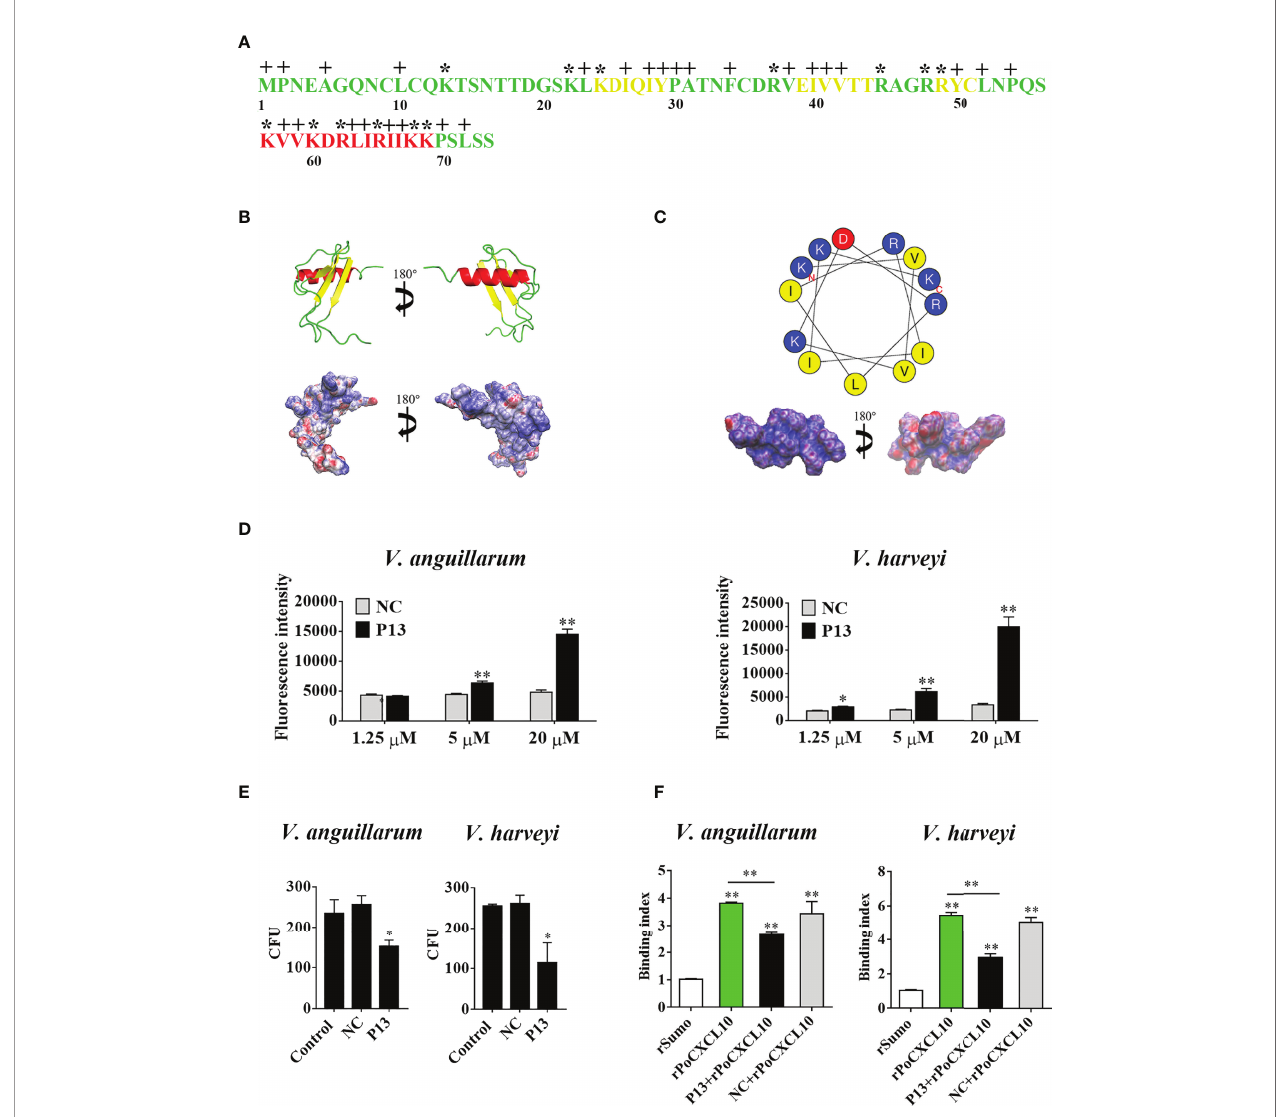
FIGURE 4 | The structure and antibacterial activity of P13. (A) The primary structure of PoCXCL10. Sequences in green, yellow, and red stand for the extended coil, b - sheet and a -helix region, respectively. Positively charged residues and hydrophobic residues are marked by “ * ” and “ + ” , respectively. (B) The secondary structure (upper) and electrostatic surface potential (lower) of PoCXCL10. In the upper panel, green, yellow, and red stand for coil, b -sheet, and a -helix, respectively. In the lower panel, the positive- and negative-charged regions are in blue and red, respectively. (C) The helical wheel (upper) and solvent accessibility representation (lower) of P13. In the upper panel, the residues that are positively charged, negatively charged, and hydrophobic are in blue, red, and yellow, respectively. In the lower panel, the hydrophilic and hydrophobic regions are in blue and red, respectively. (D) Vibrio anguillarum and Vibrio harveyi were incubated with different concentrations of FITC-labeled P13 or the negative control peptide (NC), and positive binding was determined by measuring fl uorescence intensity. (E) V. anguillarum and V. harveyi were incubated with P13, NC, or PBS (control) for 4 h. The bacteria were plated on LB plates and incubated at 28 °C for 12 h. The number of colony-forming unit (CFU) on the plates was counted and shown on the right. (F) V. anguillarum and V. harveyi were pre-incubated with or without P13 or NC, and then incubated with rPoCXCL10. Bacteria-bound protein was detected by ELISA. For panels (D – F) , values are the means of triplicate experiments and shown as means ± SD. * p < 0.05, ** p <